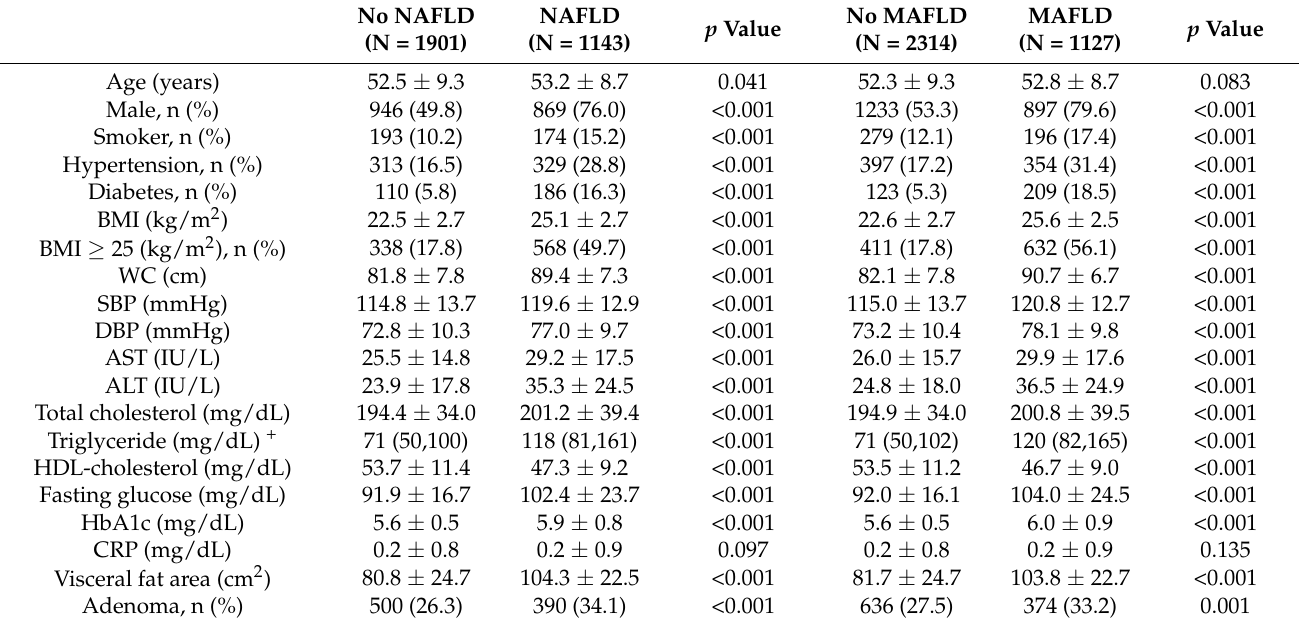
Table 1. Comparison of subjects’ baseline characteristics according to NAFLD and